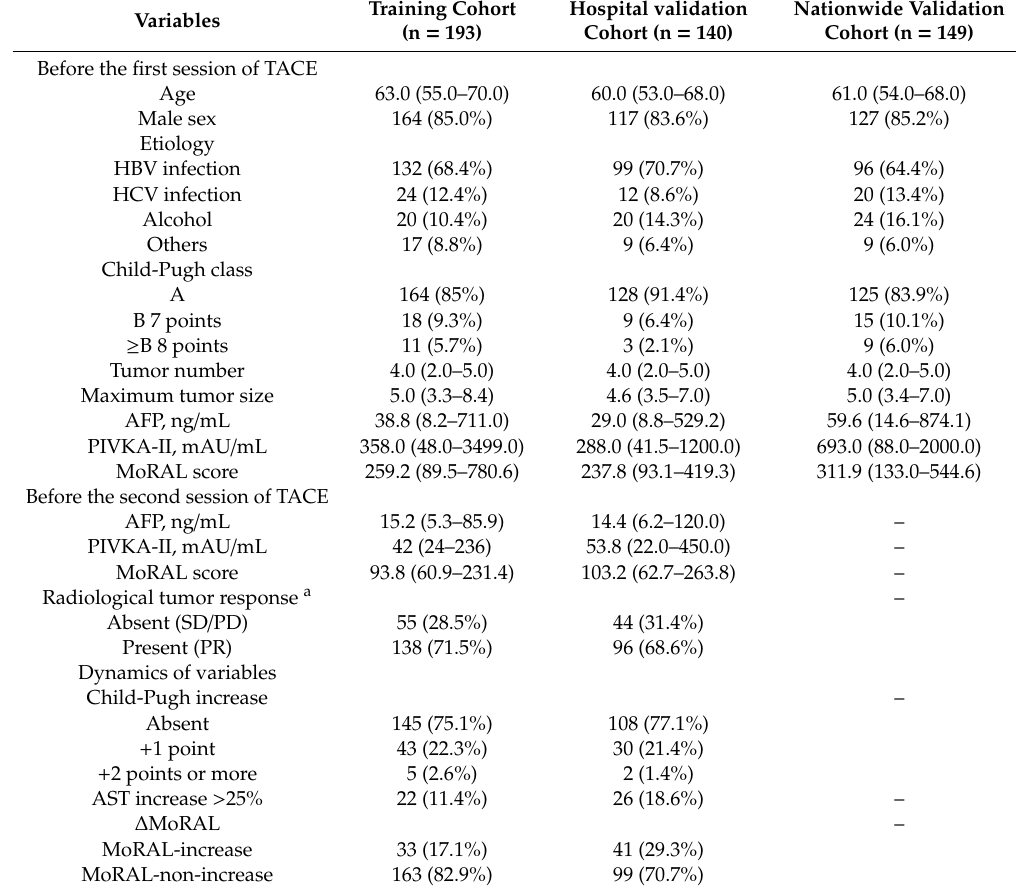
Table 1. Clinical characteristics in the three study